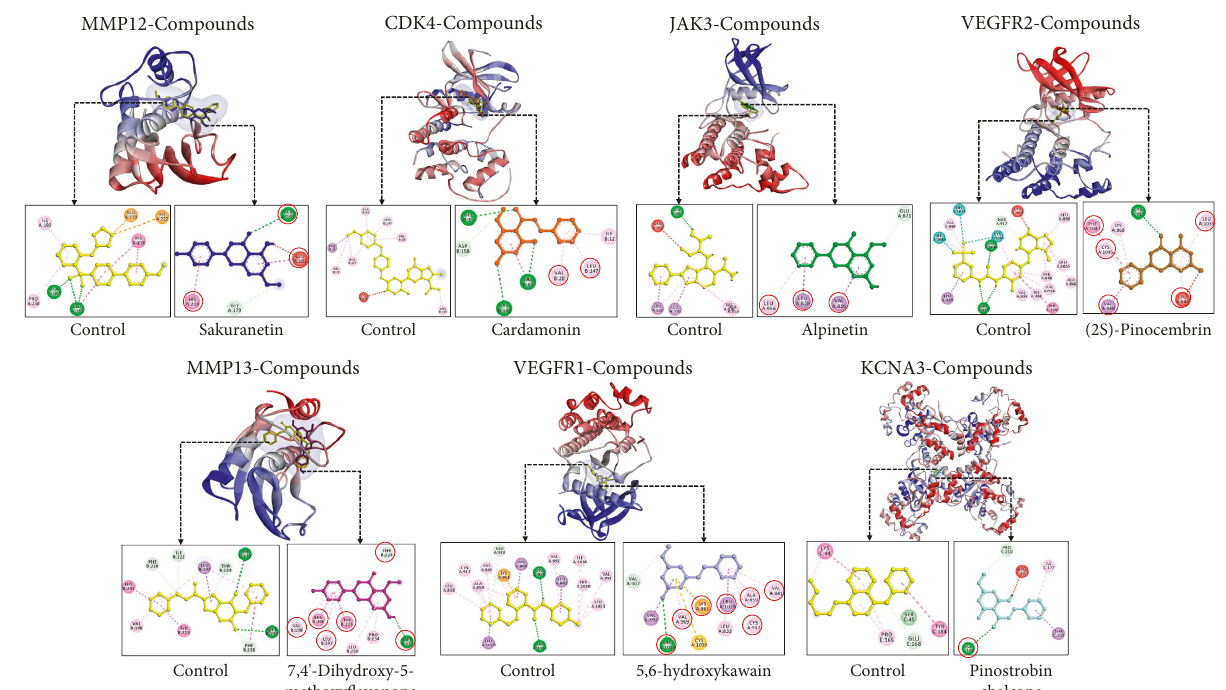
Figure 3: Molecular docking simulation results. The red circle indicates the same residue as the control.